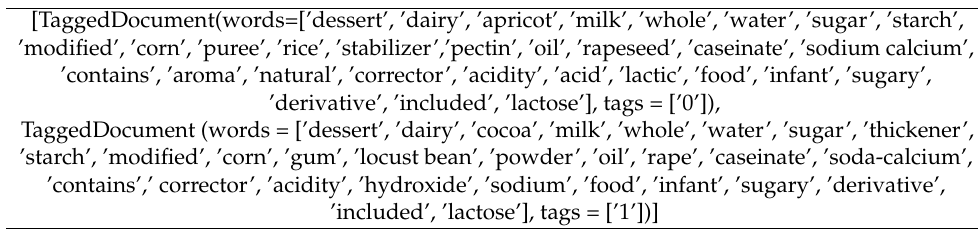
Table 18. The first two des ( p ) by